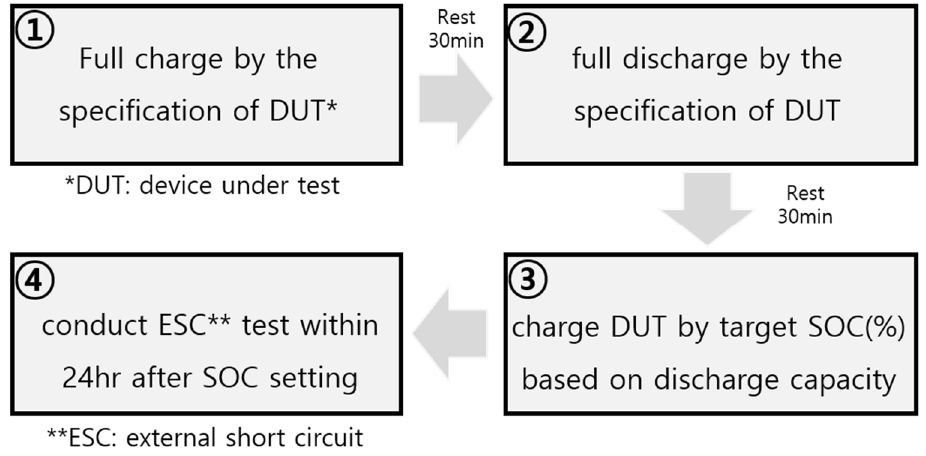
Figure 4. Preprocess of SOC setting for Li-ion battery’s external short-circuit test.